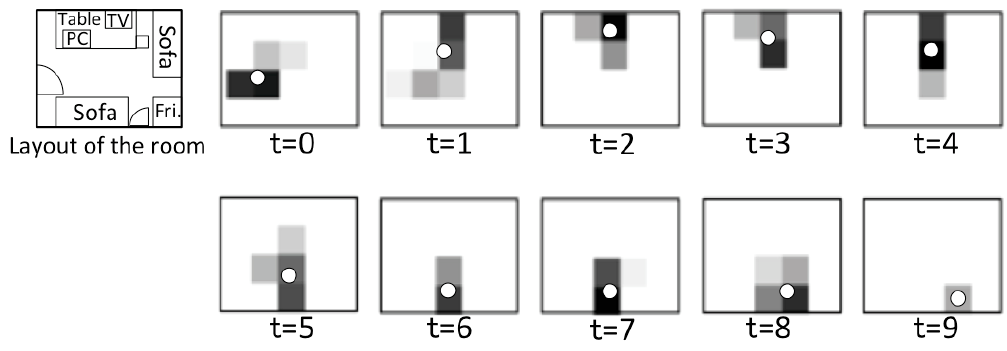
Figure 4. Top view image sequence of a series of activities (the duration of walking, tidying the table, sitting on sofa, switching TV programs, leaving the room). Each image is selected in every two seconds. The gray level corresponds to the pixel value (darker is higher), each white dot shows the estimated position by Equation (2) at time t